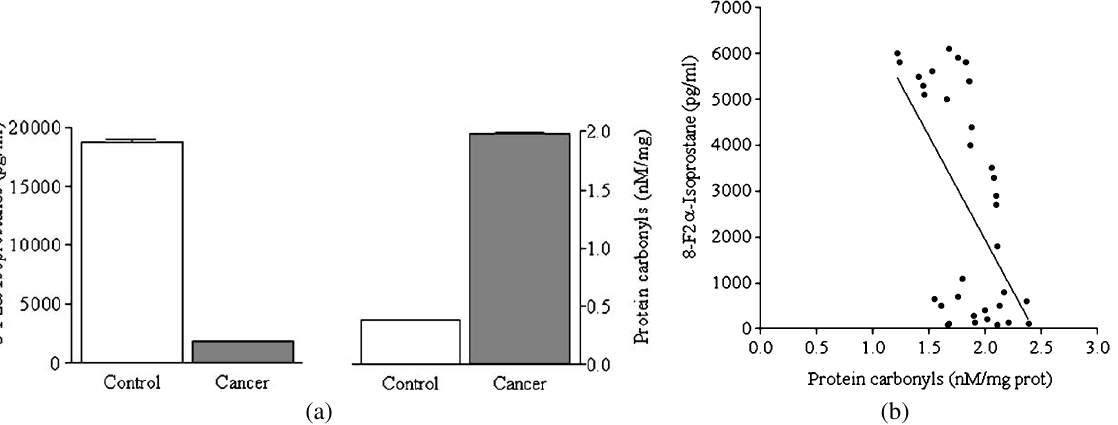
Fig. 3. Relationship between the levels of 8-F 2 α -isoprostanes and protein carbonyls in NAF collected from Control and Cancer women. In the same subset of women analysed in our previous study for NAF 8-F 2 α -isoprostanes [25], we evaluated also NAF concentrations of protein carbonyls (Control n = 113, Cancer n = 34). (a) Comparative representation of the opposite behaviours of protein and lipid oxidative biomarkers in the same subset of NAFs (8-F 2 α -isoprostanes: 18743 vs. 1803 pg/ml, Control vs. Cancer respectively, p < 0 . 0001 – Protein carbonyls: 0.384 vs. 1.980 nM/mg protein, Control vs. Cancer respectively, p < 0 . 0001). (b) Linear regression analysis of NAF 8-F 2 α -isoprostane and protein carbonyl levels in the same subset of Cancer women (slope − 4503 ± 1155, r 2 = 0 . 322, p = 0 .